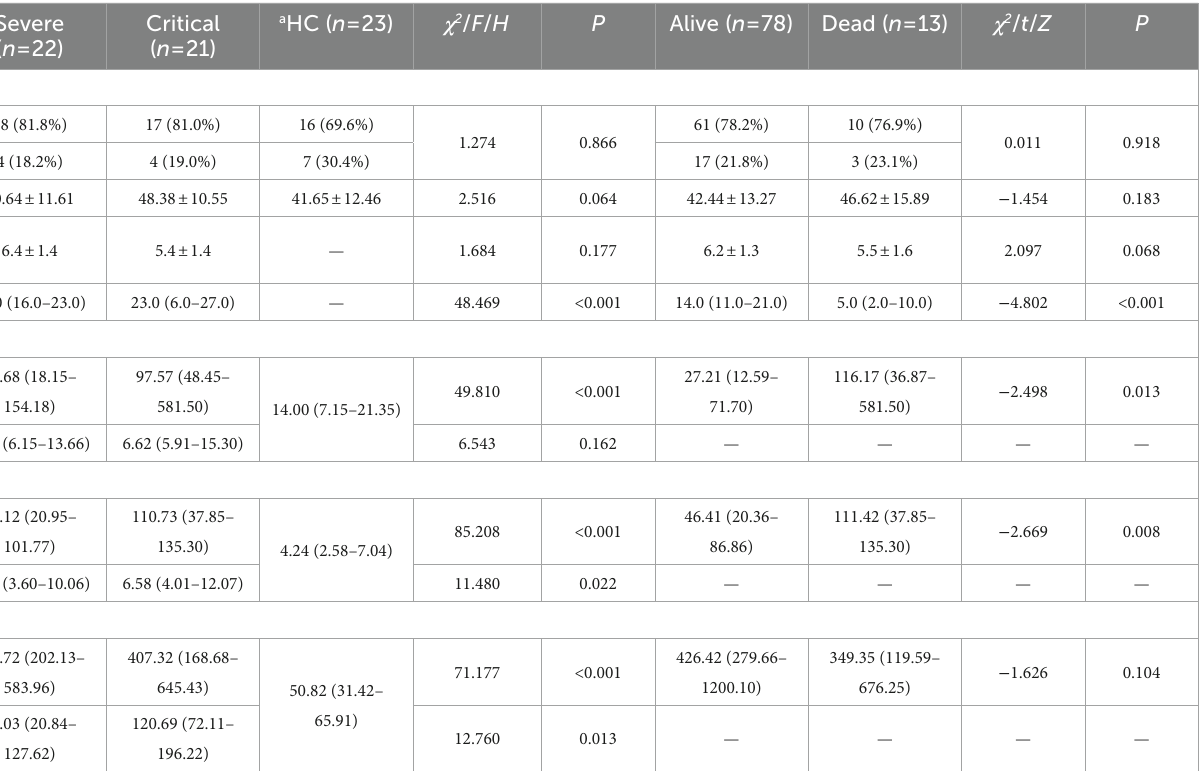
TABLE 1 Demographic, clinical, and laboratory parameters of the study